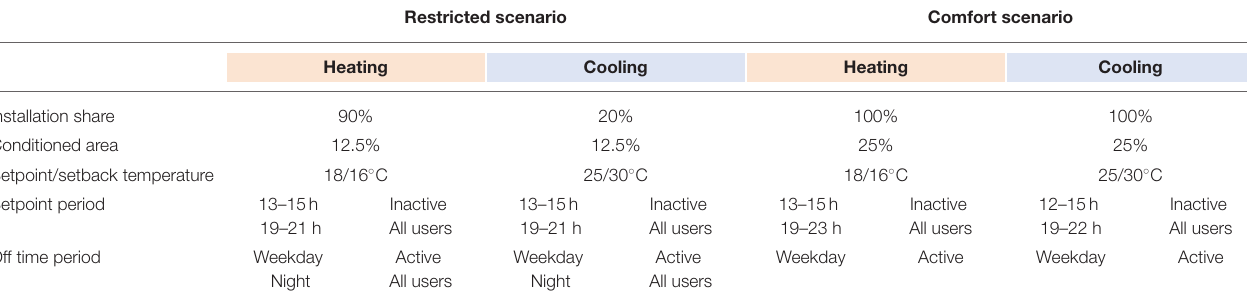
TABLE 3 | VSA thermal scenarios parametrisation.